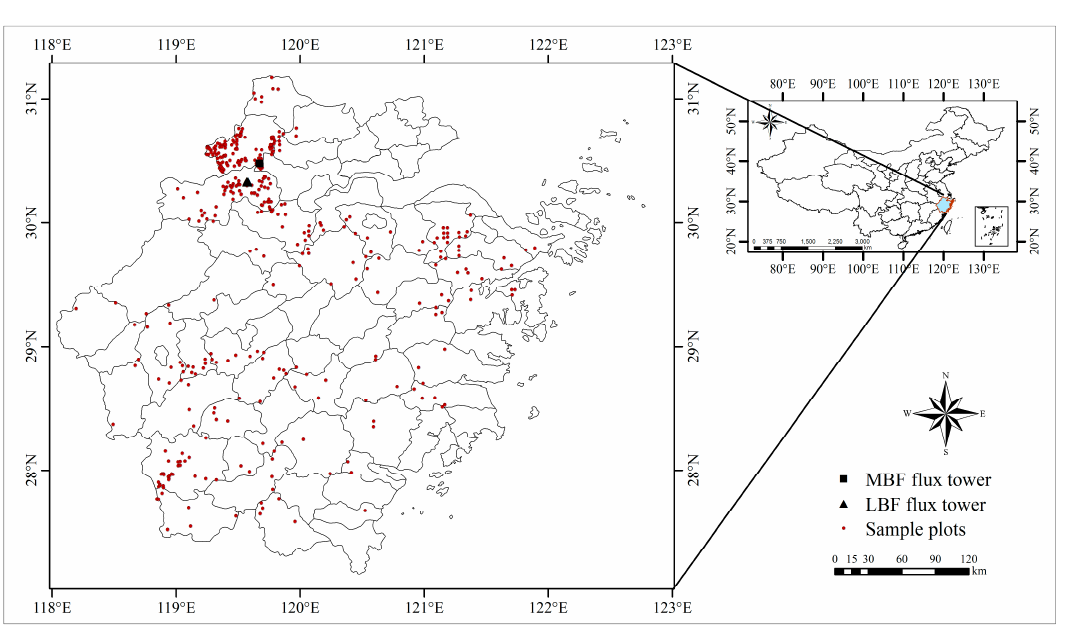
Figure 1. The study area and the sample plots of bamboo forest.